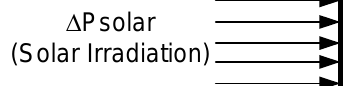
Figure 3. Block diagram of PV dynamics system.